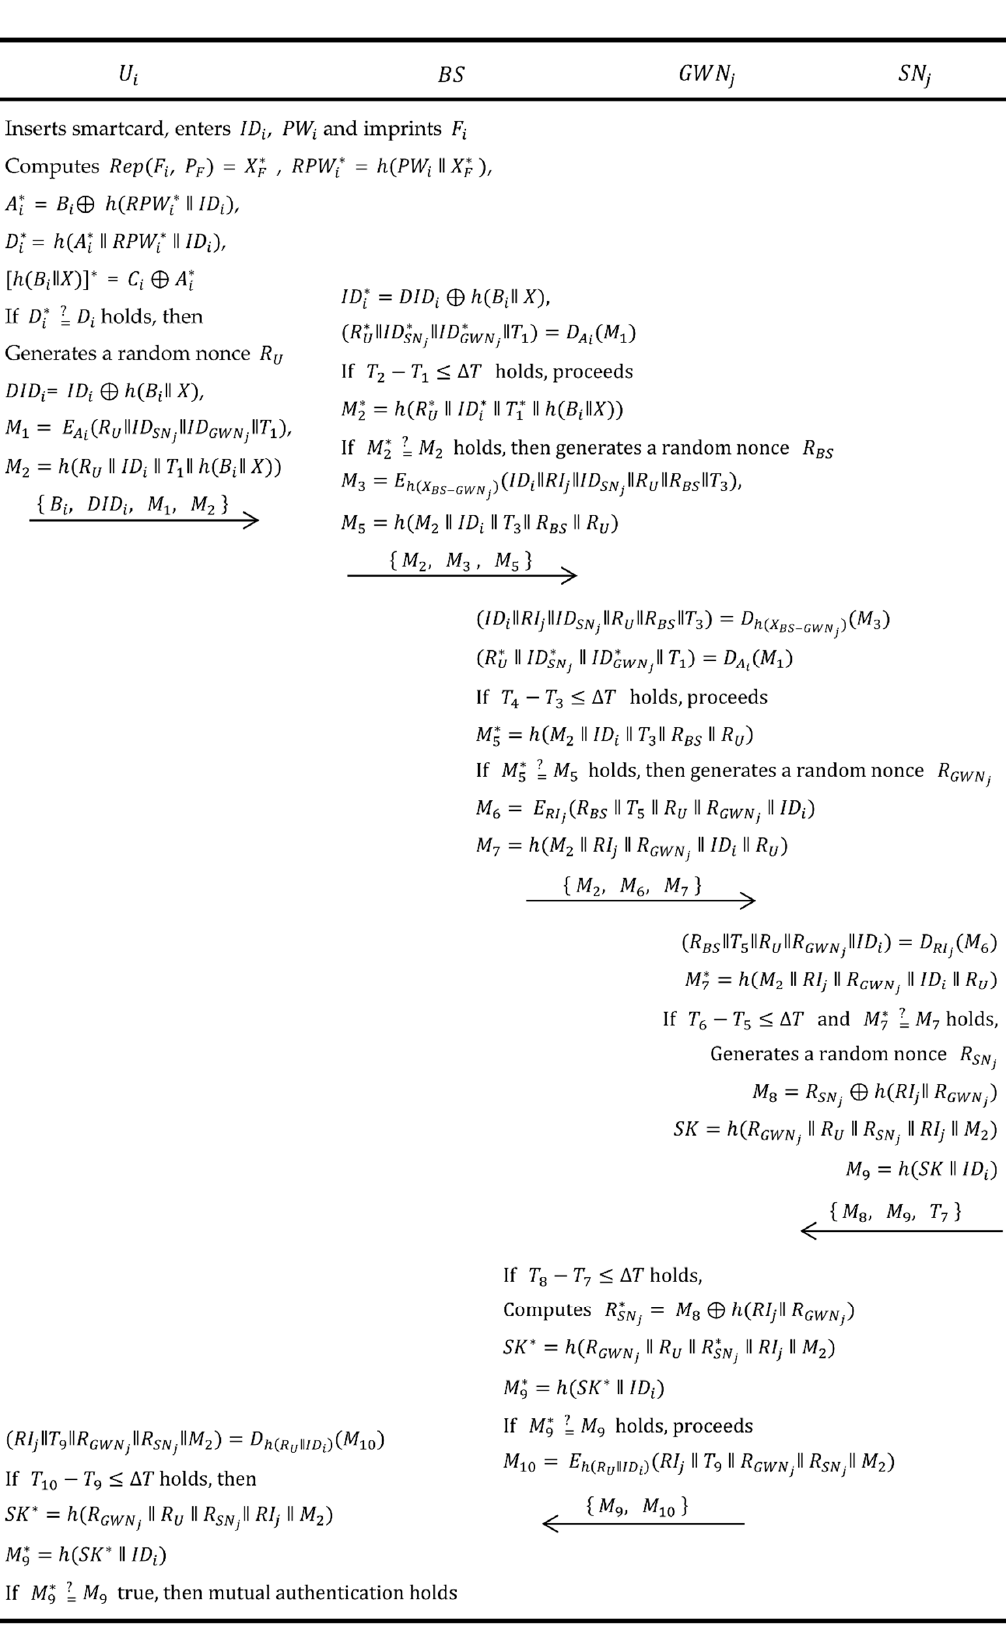
Figure 3. Login, authentication and key agreement phase of Ali et al.’s scheme.